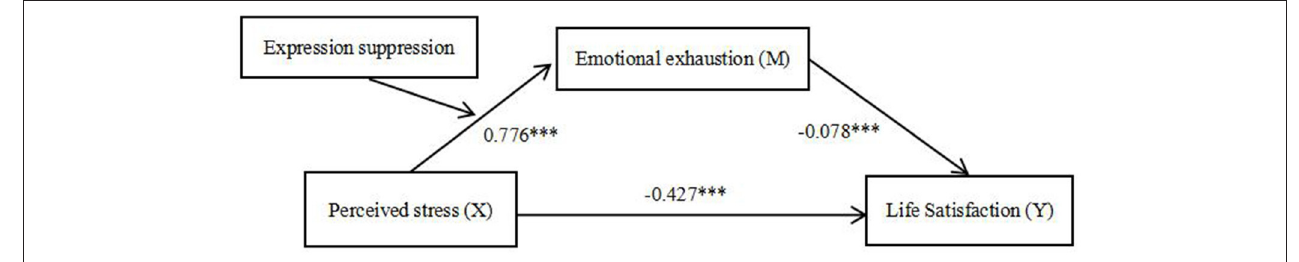
FIGURE 2 | The finalized moderated mediation model ( n = 1,372). *** p <